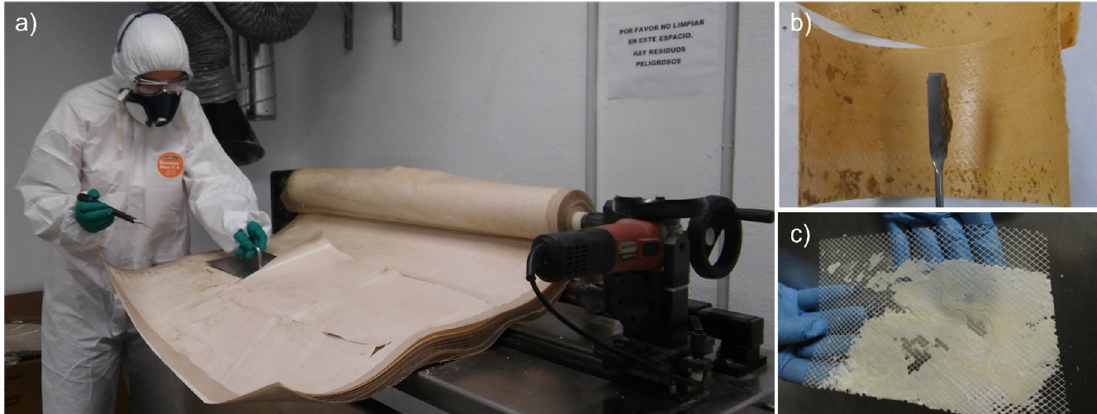
Figure 4. ( a ) Opened RO module and extraction of membrane and spacer samples. Reproduced with permission from Ref. [105]. Copyright 2022, A. Lejarazu-Larrañaga et al., ( b ) taking membrane fouling samples for analysis (presumably organic fouling), ( c ) a sample of a turbulence promoter (feed spacer) with scaling deposits.